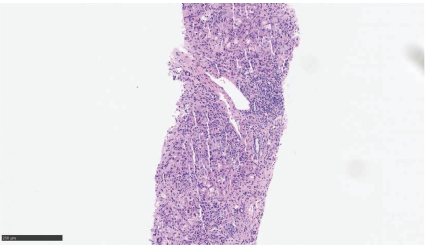
Figure 1: Tis low-power (100x) image of the second liver biopsy shows a moderate portal lymphoplasmacytic infltrate with in- terface activity.